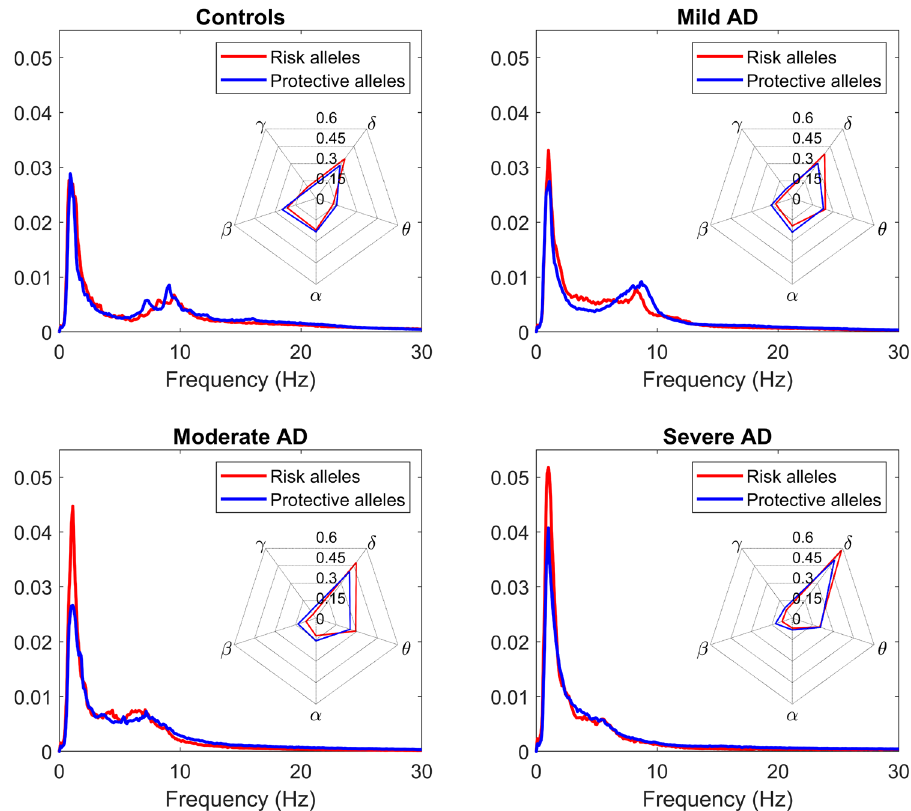
frequency band are shown for the four groups (Controls, Mild AD, Moderate AD, and Severe